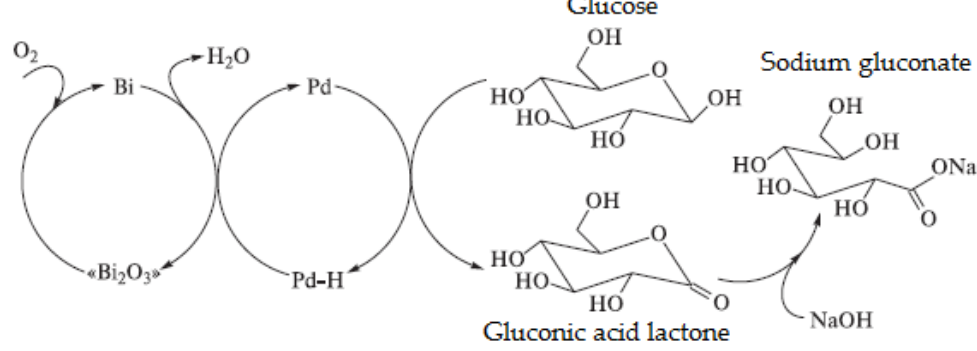
Figure 14. Glucose oxidation mechanism in the presence of the palladium-bismuth catalyst.